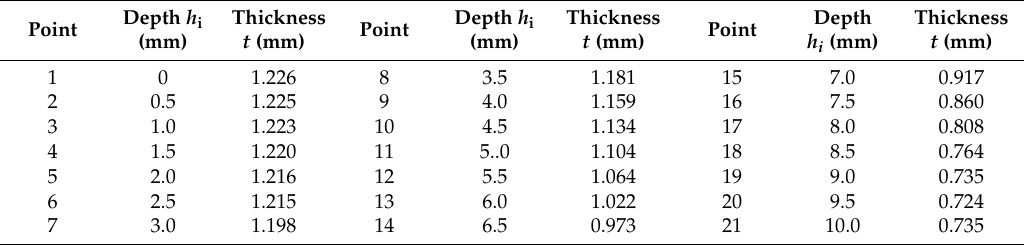
Figure 7. Frontal view of the aluminum sample. Thickness variation along the sample wall was obtained by 3D scan blue light technology equipment. Table 2. Experimental data that shows wall thickness variation as a function of the sample forming